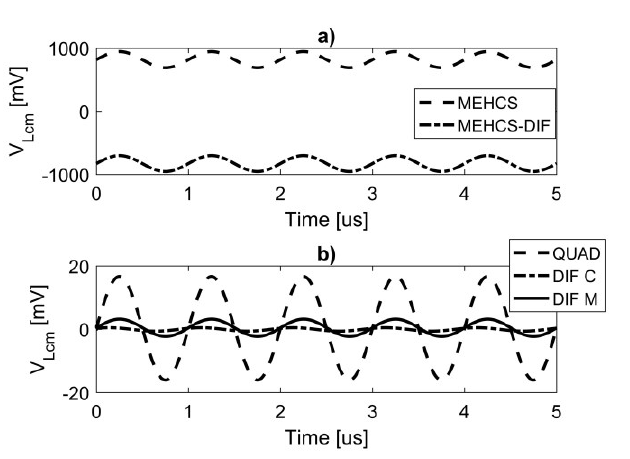
Fig.18: Simulated common mode load voltage ( V Lcm ) of the mirrored group and proposed group at time domain in 1 MHz.